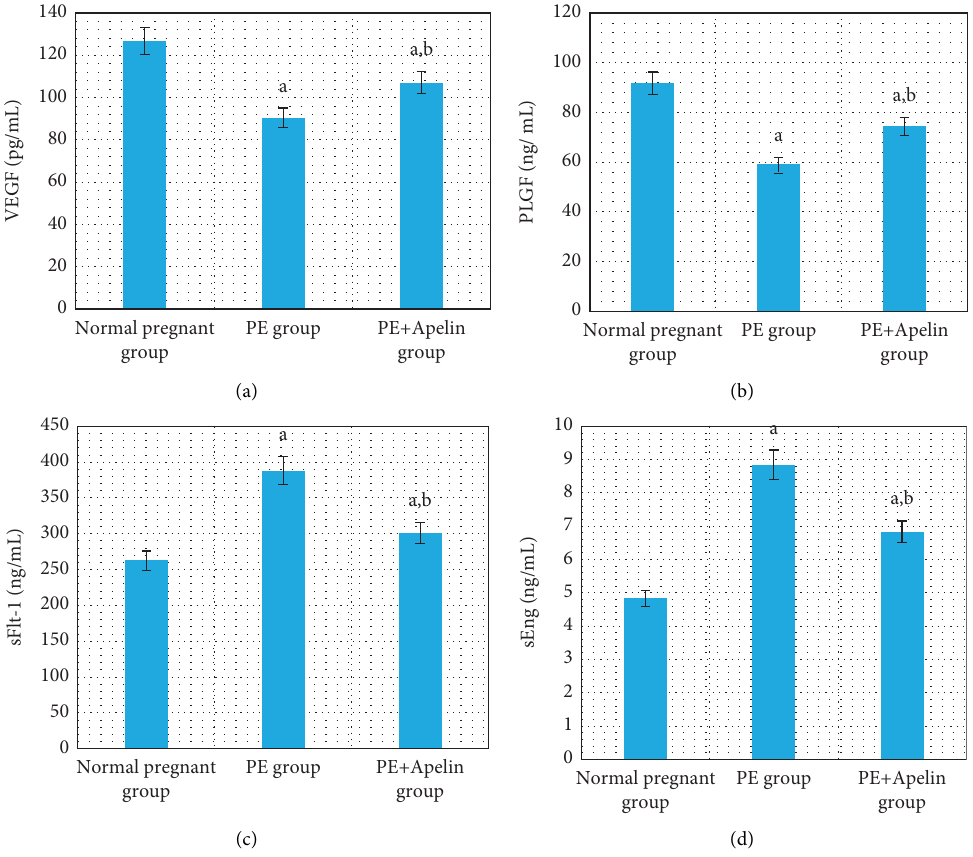
Figure 4: (a)–(d) Serum VEGF, PLGF, sFlt-1, and sEng in all studied groups.